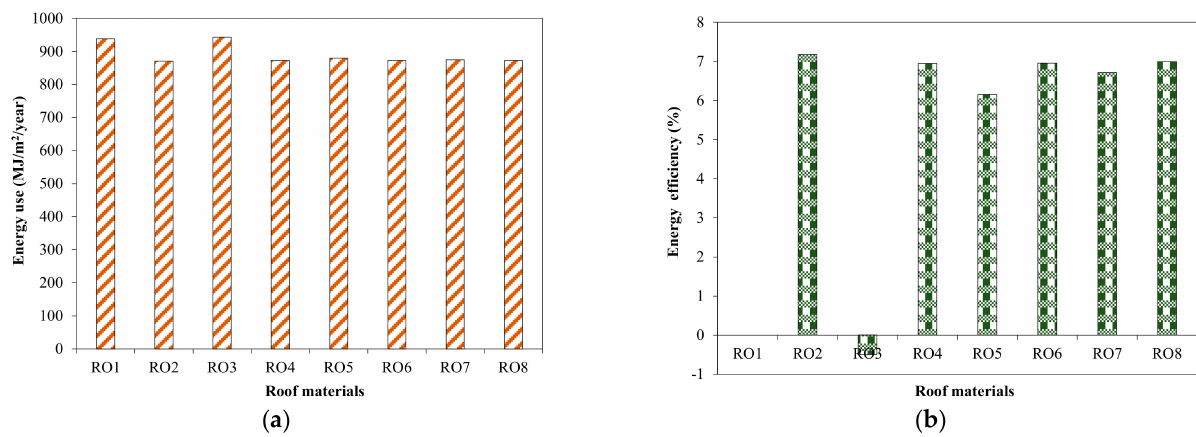
Figure 13. Effect of roof materials on energy use in office building. ( a ) Energy use; ( b )